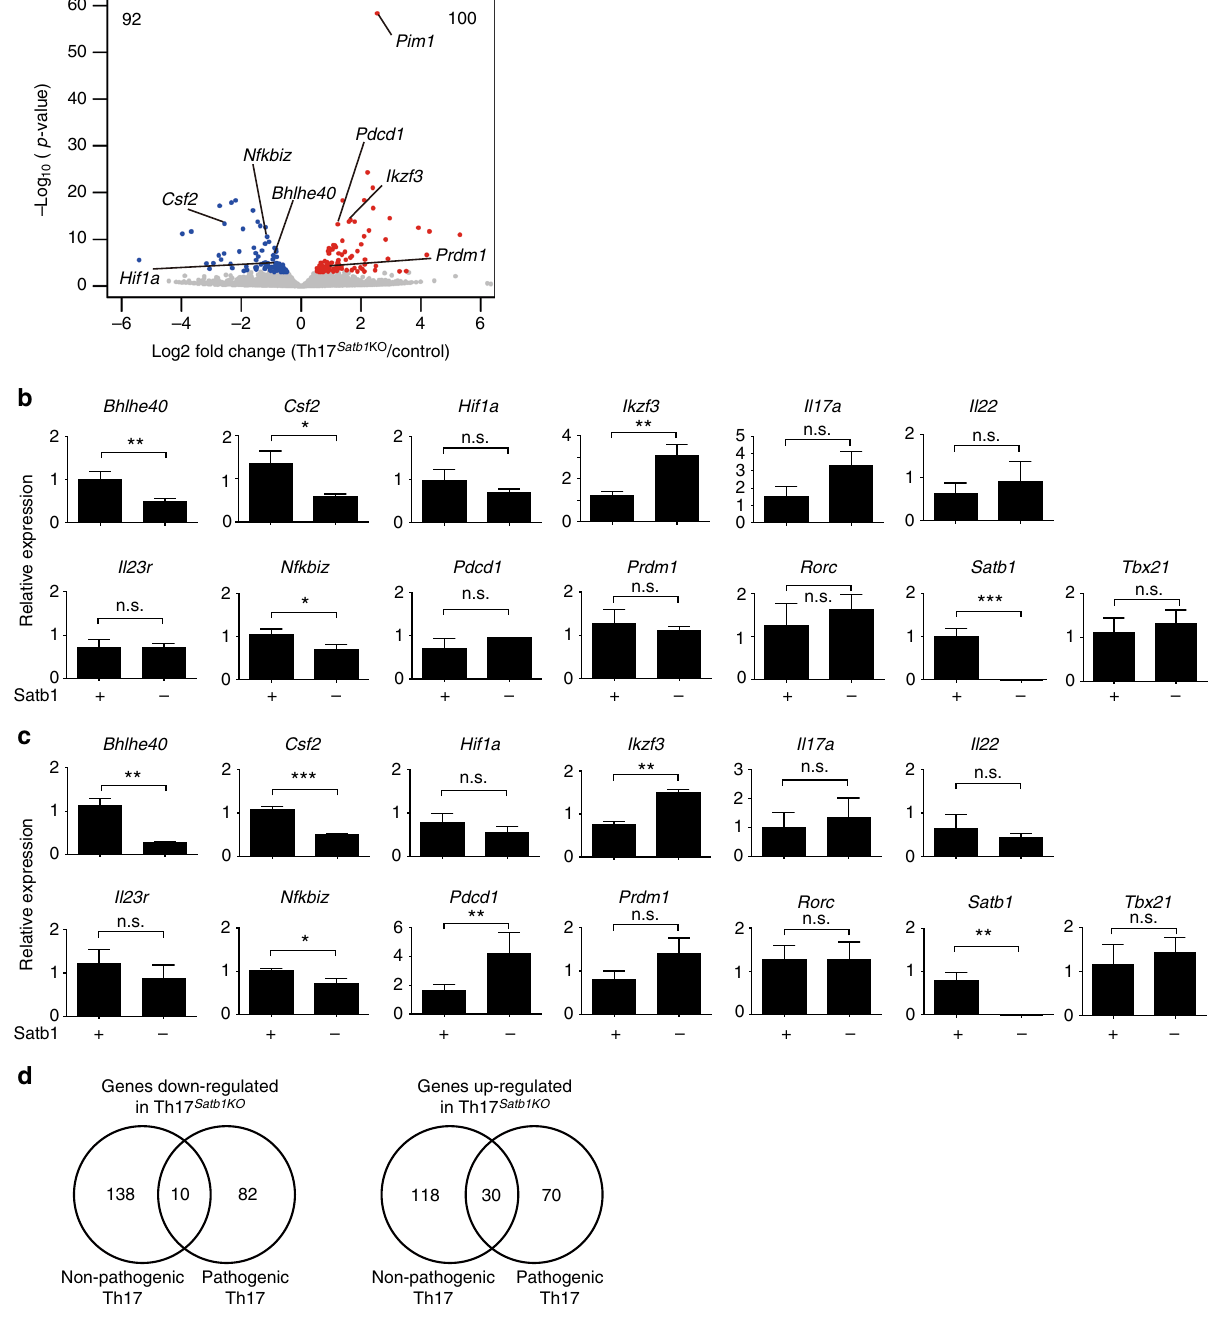
Fig. 4 Differential gene expression in pathogenic and non-pathogenic Th17 cells from control and Th17 Satb1 KO mice. a RNA-seq analysis of eYFP + CD4 + T cells from the spinal cord of control and Th17 Satb1 KO mice after EAE induction. eYFP + Th17 cells were sorted at the peak of the disease (14 days after EAE induction). The volcano plot shows the differential gene expression between the Th17 Satb1 KO versus control eYFP + CD4 + T cells. The genes up-regulated in Th17 Satb1 KO eYFP + CD4 + T cells are shown in red, and the genes down-regulated are shown in blue. Two biological replicates were analyzed. b , c qPCR of eYFP + CD4 + T cells from the draining LNs ( b ) and spinal cord ( c ) as in ( a ) for the expression of Bhlhe40 , Csf2 , Hif1a , Ikzf3 , Il17a , Il22 , Il23r , Nfkbiz , Pdcd1 , Prdm1 , Rorc , Satb1 , and Tbx21 . eYFP + Th17 cells from the draining LNs were sorted on days 7 – 14 after EAE induction, and eYFP + Th17 cells from spinal cord was sorted at the peak of the disease (14 ± 3 days after EAE induction). d Venn diagram presenting overlap of the number of down-regulated or up- regulated genes between PP eYFP + CD4 + T cells (non-pathogenic) and eYFP + CD4 + T cells (pathogenic) from the in fl amed spinal cord of Th17 Satb1 KO mice after EAE induction. eYFP + Th17 cells were sorted at the peak of the disease (14 days after EAE induction). The bar graphs ( b and c ) show the mean ± s.d. ( n = 3). * P < 0.05, ** P < 0.001, *** P < 0.0001 (two-tailed unpaired Student ’ s t